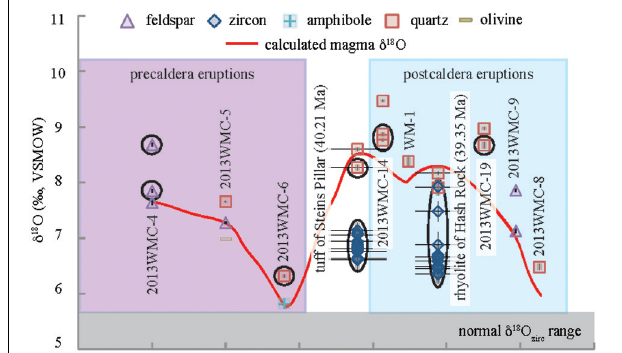
FIGURE 3 | δ 18 O vs. age for zircon, feldspar, quartz, olivine, and amphibole for rocks associated with the Wildcat Mountain caldera (References for ages are listed in the Supplementary Material). The vertical and horizontal bars through the symbols are 2 σ error for the age (if applicable) and δ 18 O analysis, respectively. A circle around the analysis indicates single grain analysis. The units analyzed are split into pre- and post-caldera subsets due to the lack of known relative ages for all units except two. The calculated magma δ 18 O curve is based on the fractionation between average zircon (1.8 (cid:2) ), quartz ( − 1 (cid:2) ), or feldspar ( ∼ 0 (cid:2) ) and the magma. The normal mantle δ 18 O zircon range (5.0–5.6 (cid:2) ) is from Valley et al. (2005).